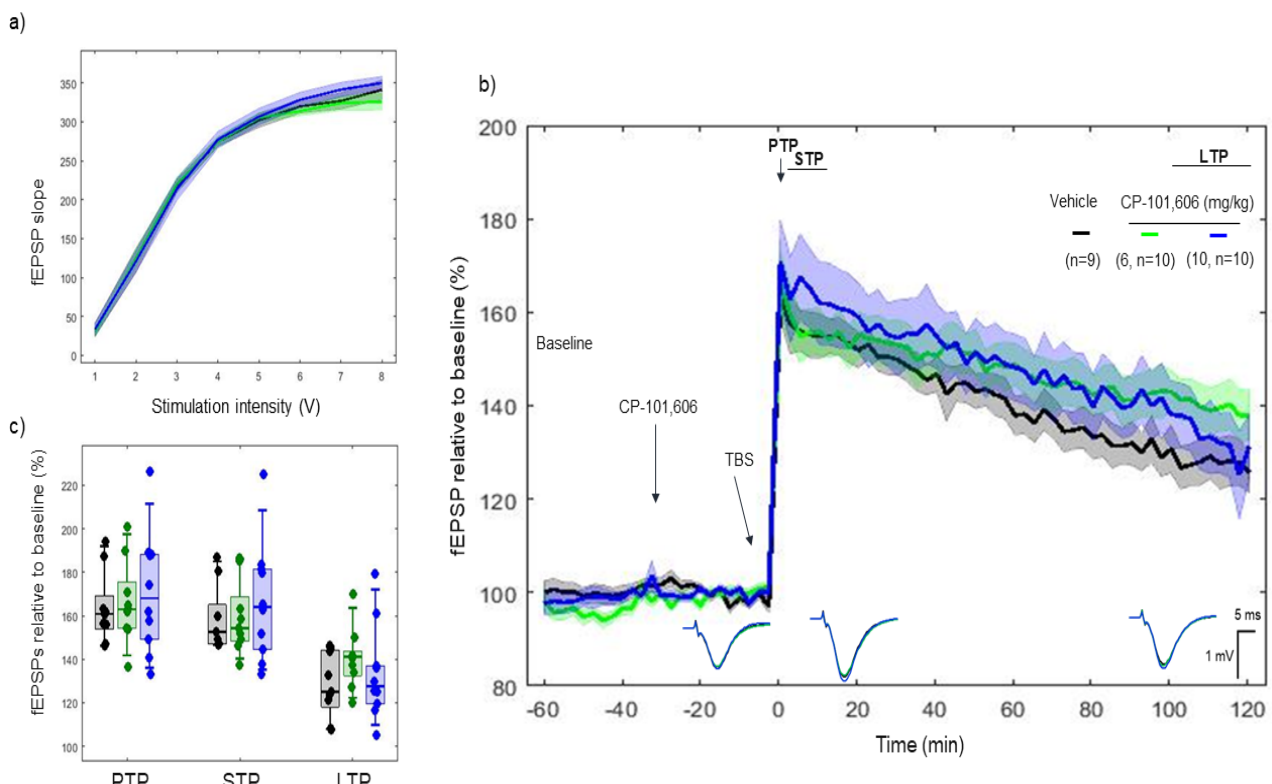
Figure 3. LTP response to CP-101606 (6 and 10 mg/kg). CP-101606 did not reduce the TBS-induced LTP response for both doses of 6 and 10 mg/kg. ( a ) Collective input/output curves of stimulation voltage and fEPSP slope overlap and no difference is observed in basal synaptic excitability prior to treatment with CP-101,606. ( b ) Basal fEPSPs before tetanization were considered indifferent as well as after tetanization, and the LTP responses of CP-101606-treated animals for both doses (green, n = 10; blue, n = 10) were not different from the LTP responses in the control group (black, n = 9). Values represent mean ± 95% confidence intervals. Outsets under the LTP curves represent average waveform field potentials during 30 min baseline prior to tetanization, 0–30 min after tetanization and 90–120 min after tetanization. Horizontal bar: 1 mV, vertical bar: 5 ms. ( c ) PTP, STP and LTP responses boxplots, p < 0.05.